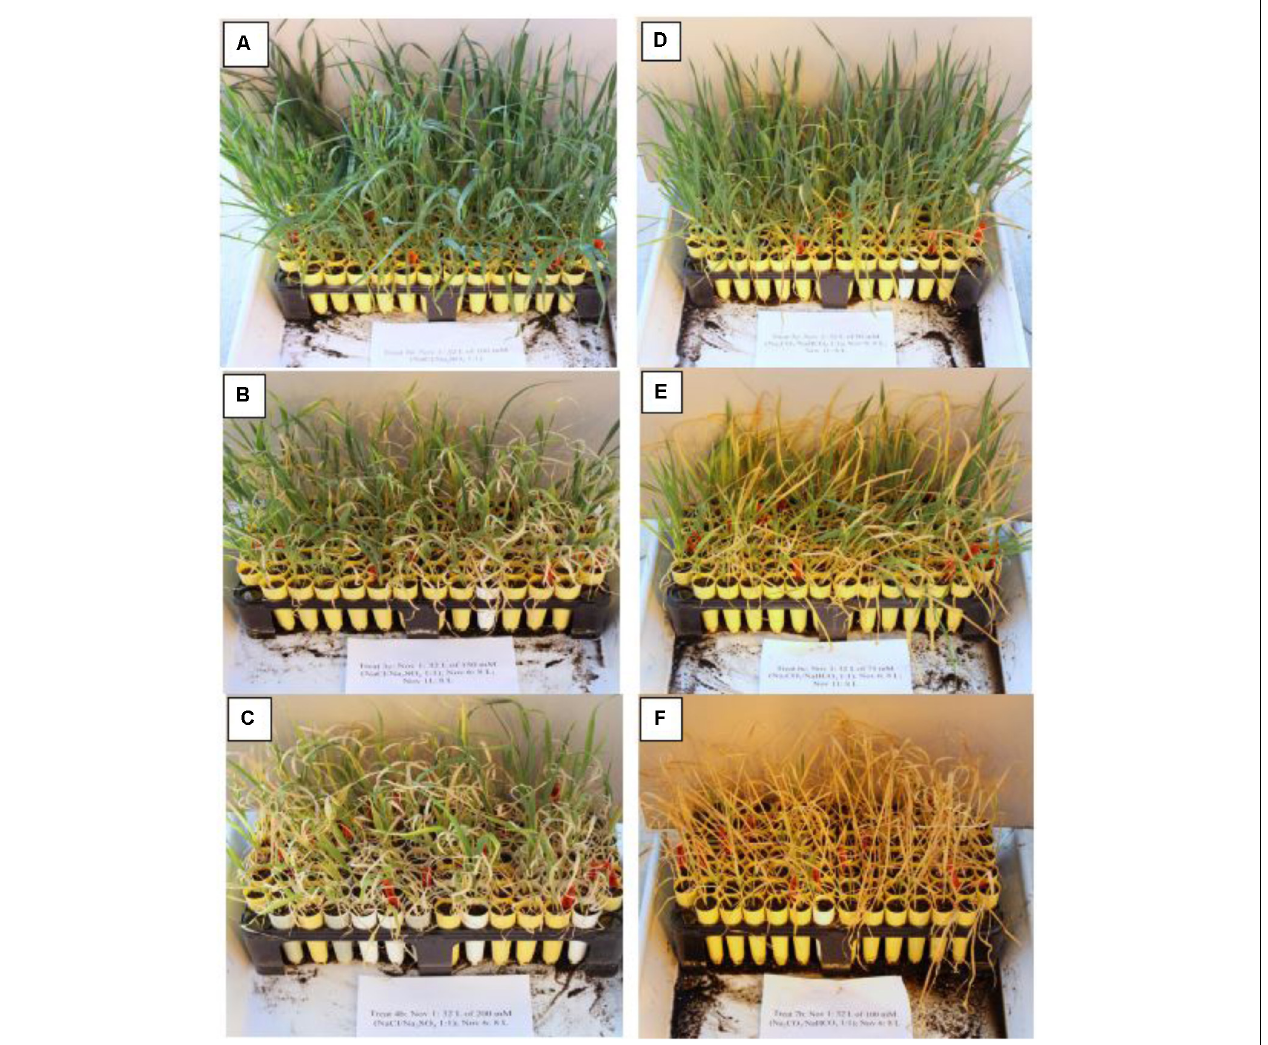
FIGURE 6 | Appearance of oat plants under salt and alkali stresses. (A–C) salt stress. (D–F) alkali stress. (A) Oat under l00 mmol L − 1 salt stress. (B) Oat under 150 mmol L − 1 salt stress. (C) Oat under 200 mmol L − 1 salt stress. (D) Oat under 50 mmol L − 1 alkali stress. (E) Oat under 75 mmol L − 1 alkali stress. (F) Oat under l00 mmol L − 1 alkali